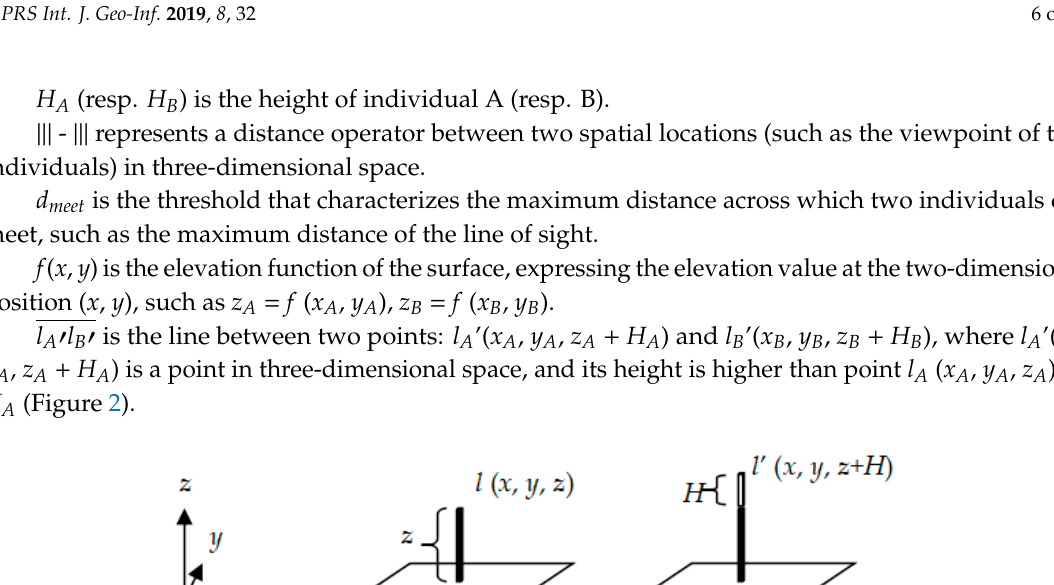
and the surface